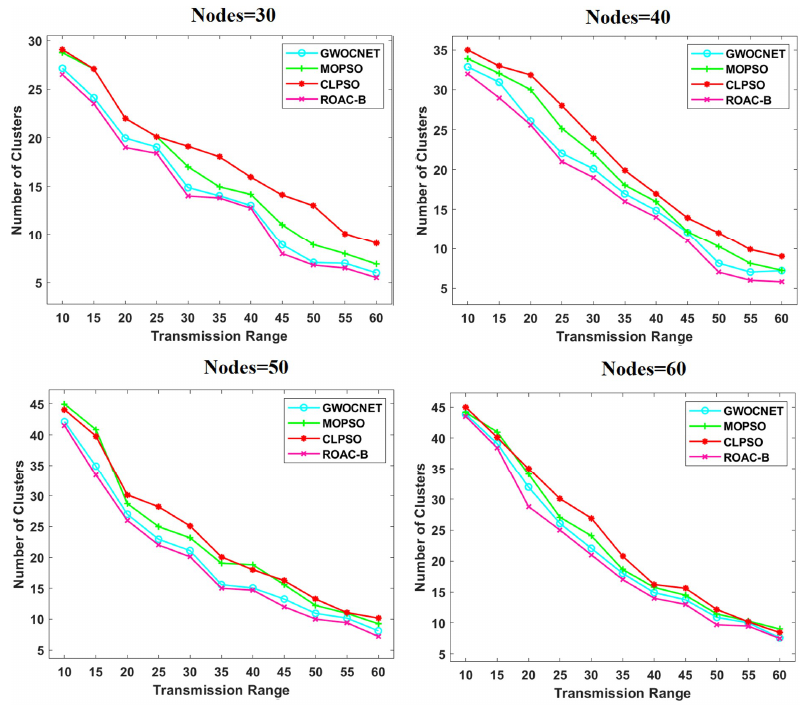
Figure 6. Number of clusters vs. transmission range in a 200 m × 200 m grid (Node count 30–60).